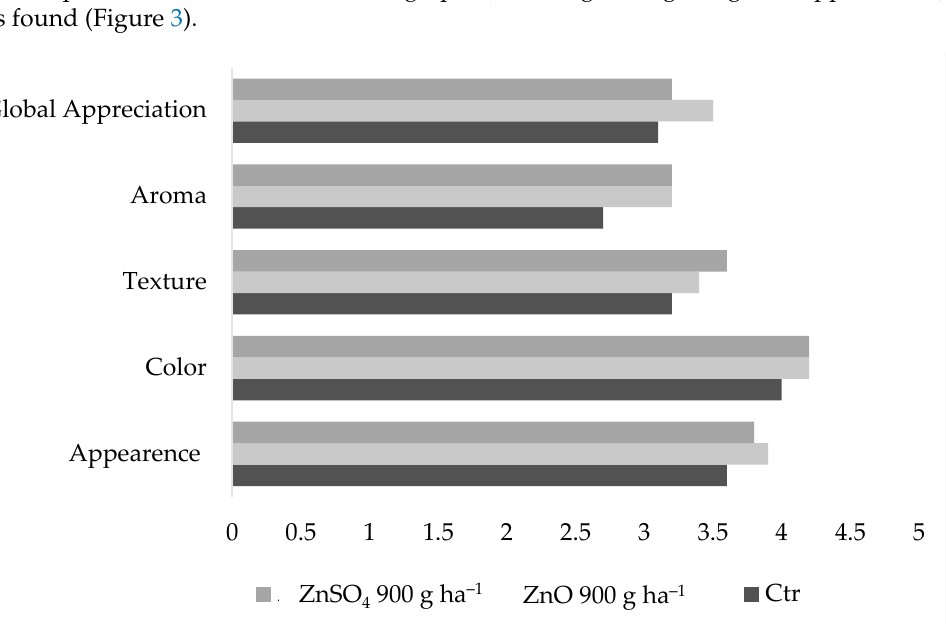
Figure 3. Mean values of sensory parameters of grapes ( Vitis vinifera L . variety Fernão Pires at harvest in the treatments of 900 g ha —1 of ZnO and ZnSO 4 .).